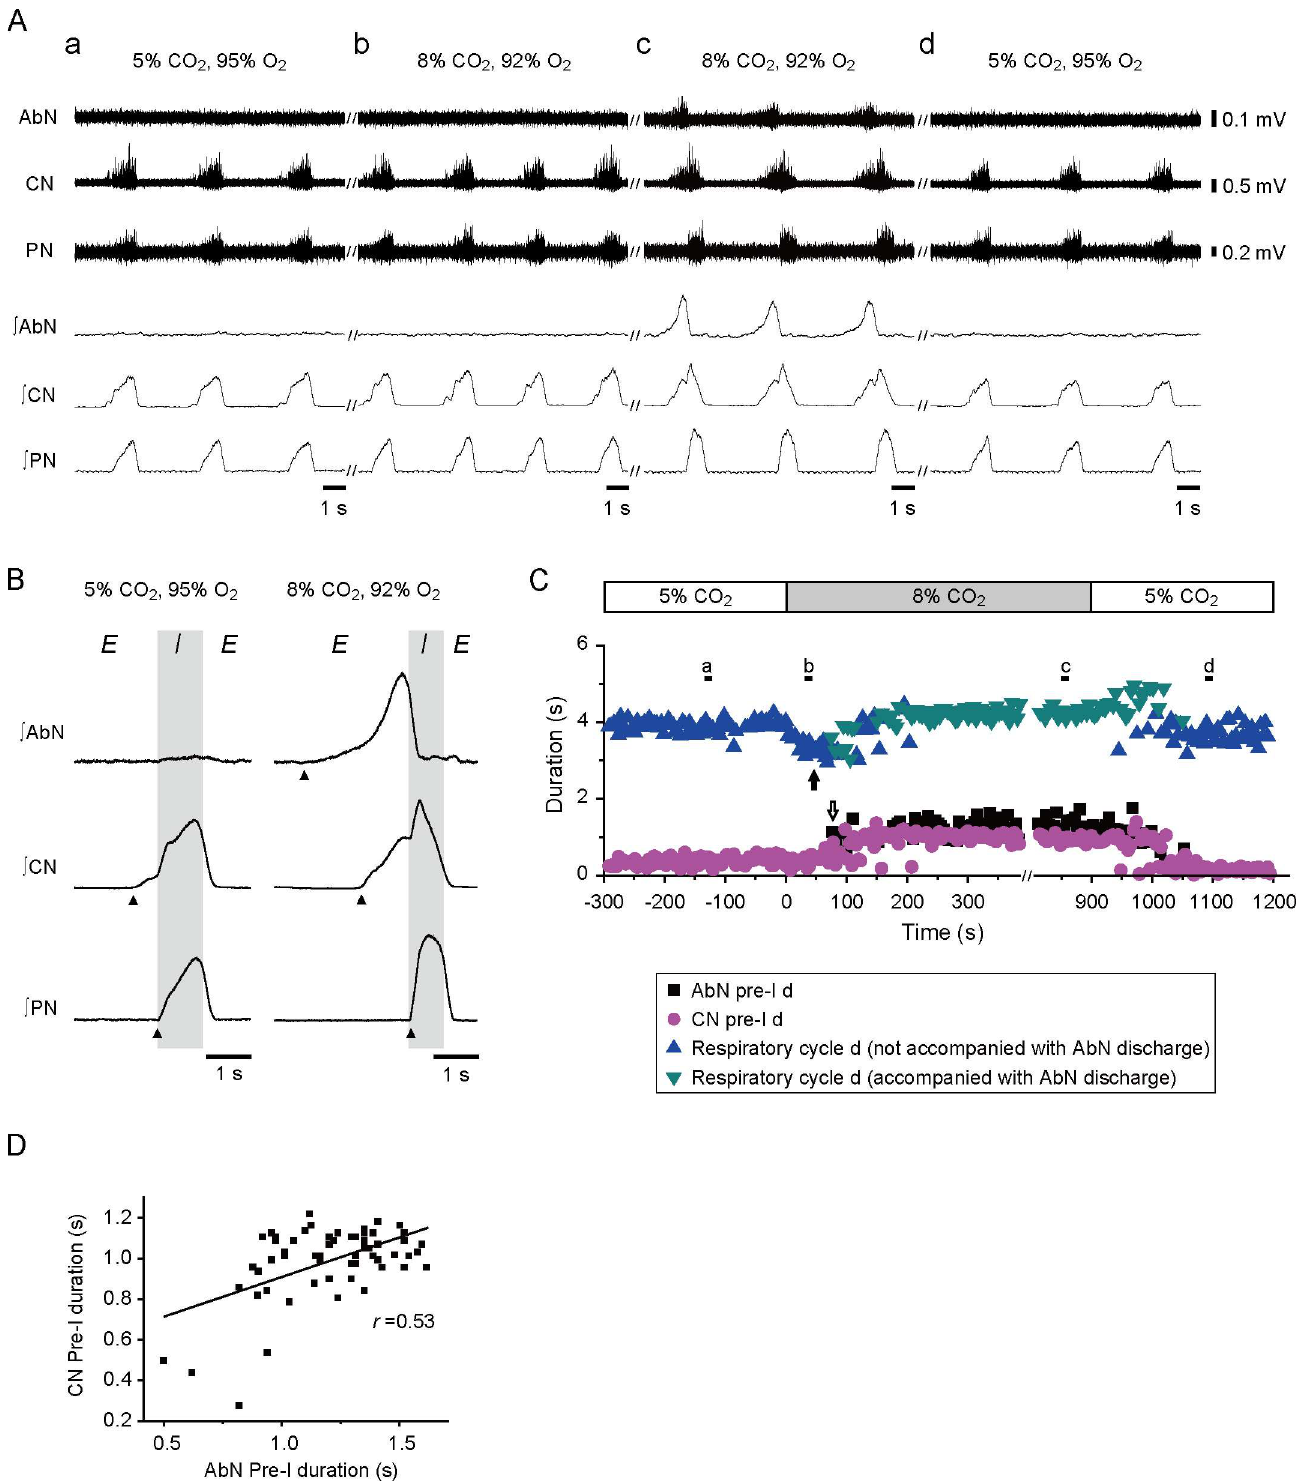
Fig 5. Correlation between abdominal nerve (AbN) activity and CN activity. (A) Originaland integratedtraces of AbN, CN, and PN activity during normocapnia (5% CO 2 , 95% O 2 ), hypercapnia (8% CO 2 , 92% O 2 ), and recovery (5% CO 2 , 95% O 2 ). (B) Traces averaged from consecutive integrated sweeps for 1 min in the preparation shown in (A). The filled arrowheadsshow the onset of nerve discharges. (C) Comparison of the durationof the AbN pre-I discharge, CN pre-I discharge,and respiratory cycle in the preparation shown in (A). Black bars show the times that the traces in (A)